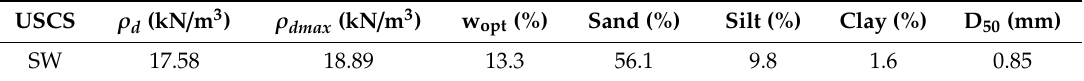
Table 1. Properties of the weathered soil used in the study.